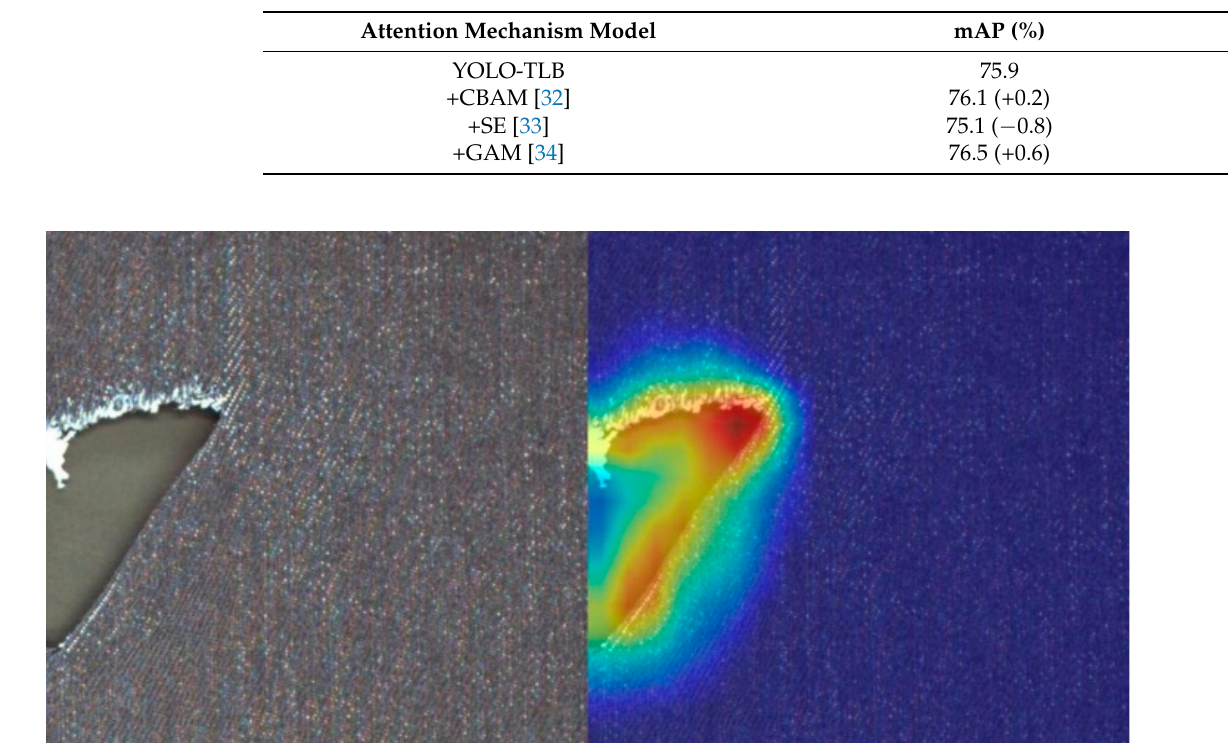
Figure 13. Attention of Eigen CAM heatmap.